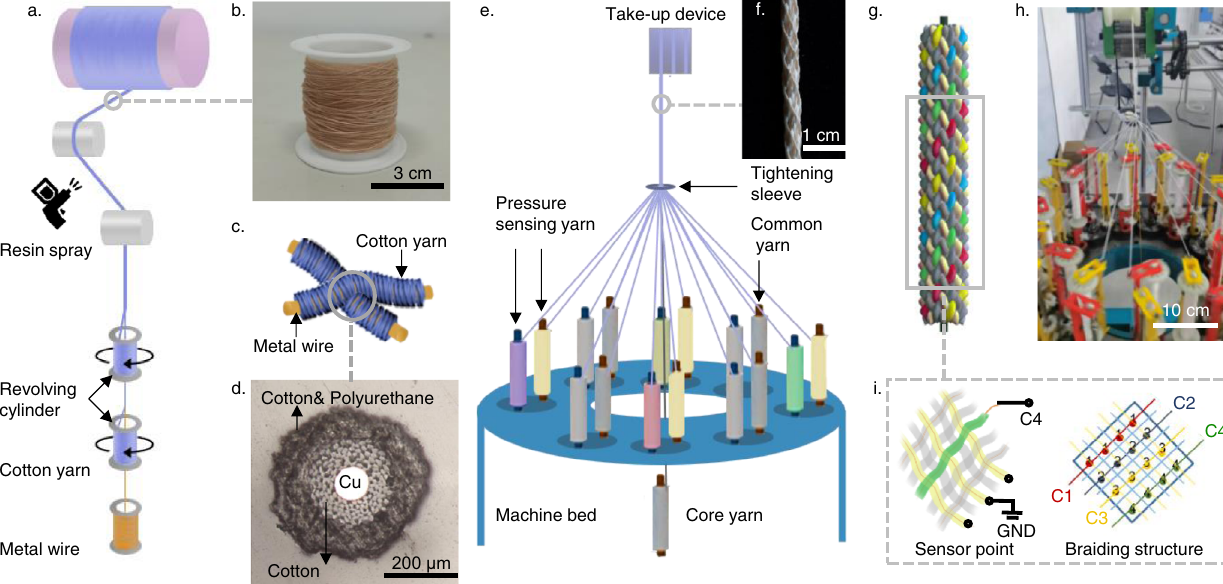
Fig. 1 | A braided electronic cord based on core-spun pressure-sensing yarns. a Schematic illustration for the fabrication of a core-spun pressure-sensing yarn. b Photograph of a core-spun pressure-sensing yarn. c Schematic illustra- tionforthecross-contactbetweenthecore-spunyarns. d Opticalmicrographof a core-spun yarn cross-section. e Schematic illustration for the fabrication of a